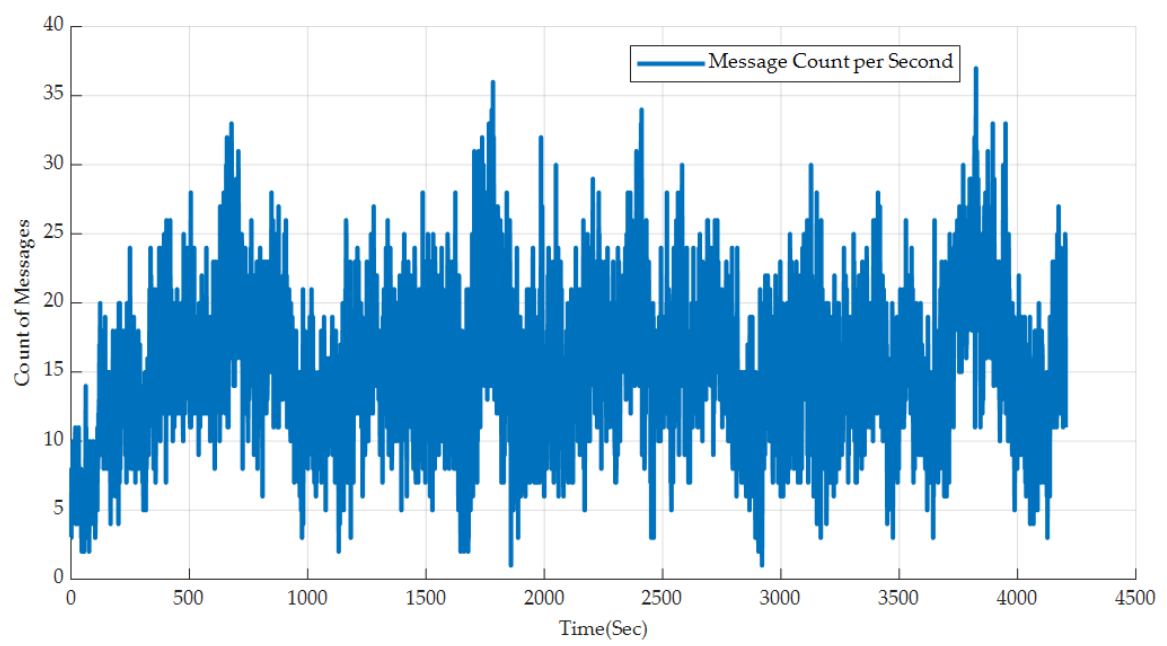
Figure 19. Number of correctly decoded messages per second during flight test.